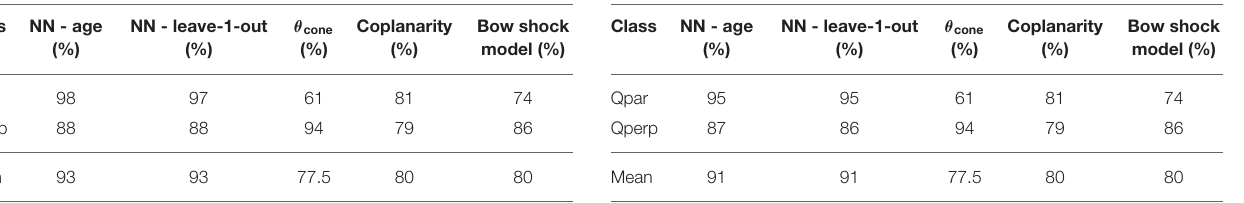
TABLE 4 | Accuracy of each method used per class. TABLE 5 | Accuracy of each method used per